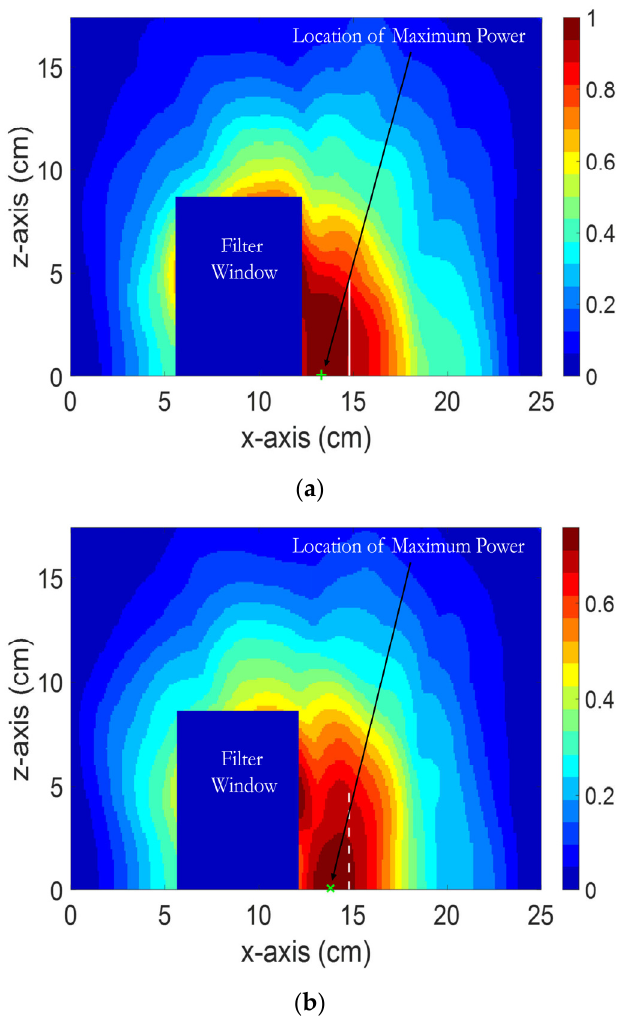
Figure 10. Distribution of the normalized maximum power over the calculation domain in absence of the source monopole antenna (mismatched media): ( a ) At cut plane y = 6.66 cm. The solid white line represents the location of the removed source monopole antenna. ( b ) At cut plane y = 8.66 cm. The white dashed line represents the projection of the removed source monopole antenna on the cut plane. The location of maximum power is shown using a green “+” sign.